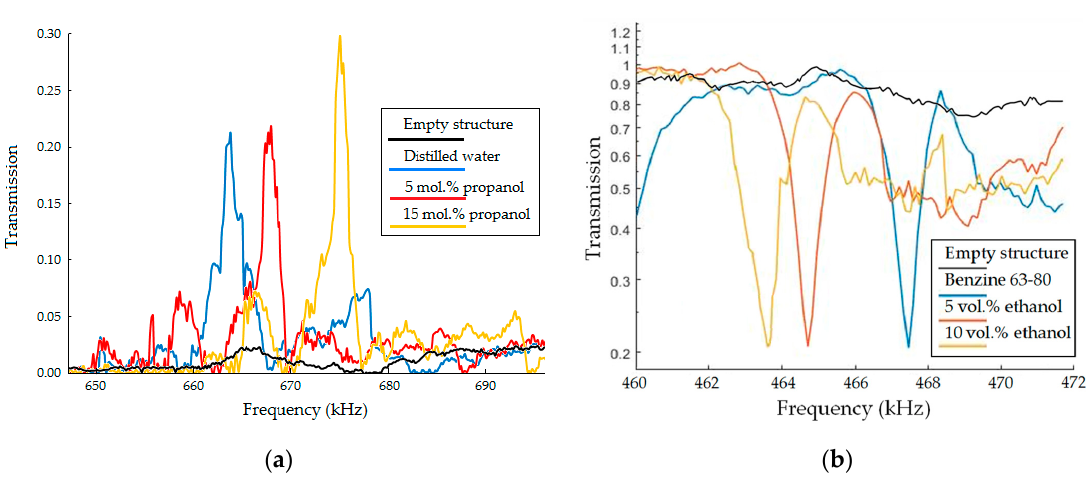
Figure 8. Experimental transmission frequency spectra of the two different sensors: ( a ) The first type of structure—the honeycomb phononic crystal with substitution type defect in form of a cylindrical hole filled with water-propanol mixtures for concentrations of 1-propanol 0, 5, and 15% by volume; ( b ) the second type of structure—solid-liquid cubic periodic arrangement of cylindrical holes filled with gasoline-ethanol mixtures for concentrations of ethanol 0, 5 and 10% by volume.